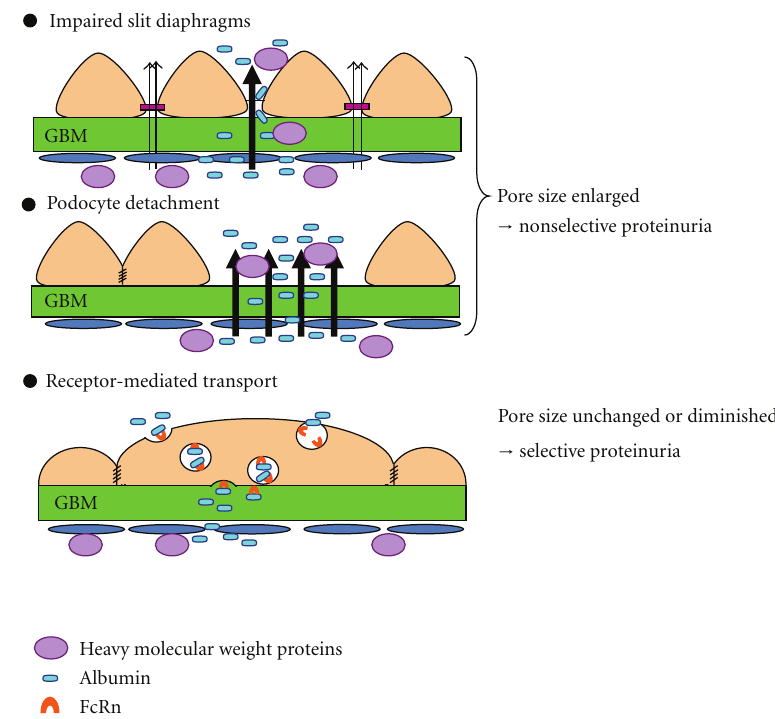
Figure 4: Possible mechanisms of albuminuria in minimal-change nephrotic syndrome. Albumin is filtered through the endothelial fenestrae, the basement membrane, and finally through the impaired slit diaphragm. Albumin is also filtered through the glomerular capillary wall where podocytes are lost by podocyte detachment or apoptosis causing enlarged slit pores and nonselective proteinuria. A mechanism of receptor-mediated albumin transport via FcRn through podocytes may explain the selective albuminuria in minimal-change